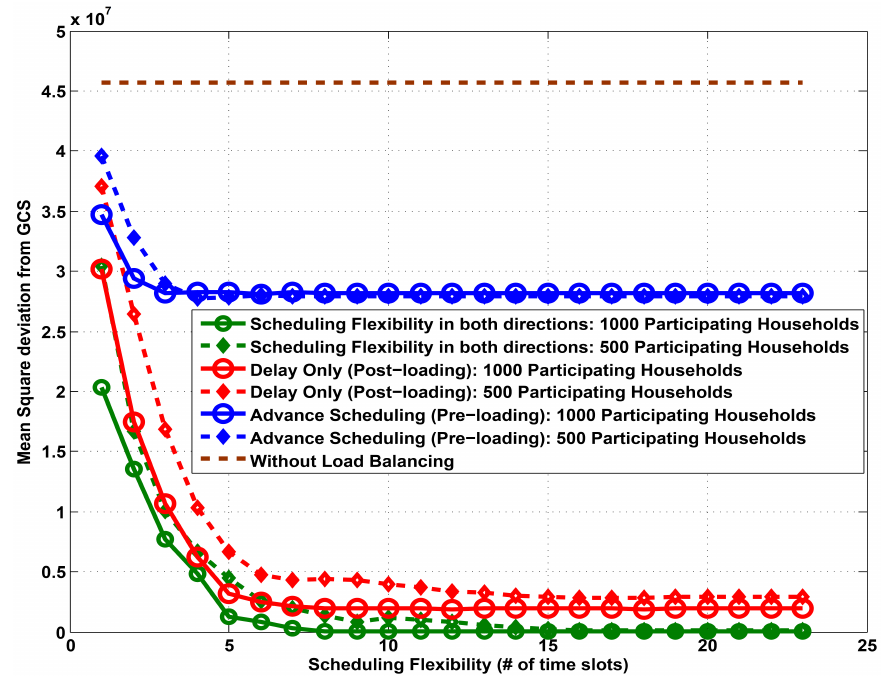
Figure 1. Mean square deviation from GCS vs . scheduling flexibility: centralized heuristic implementation with different participation rate of households.